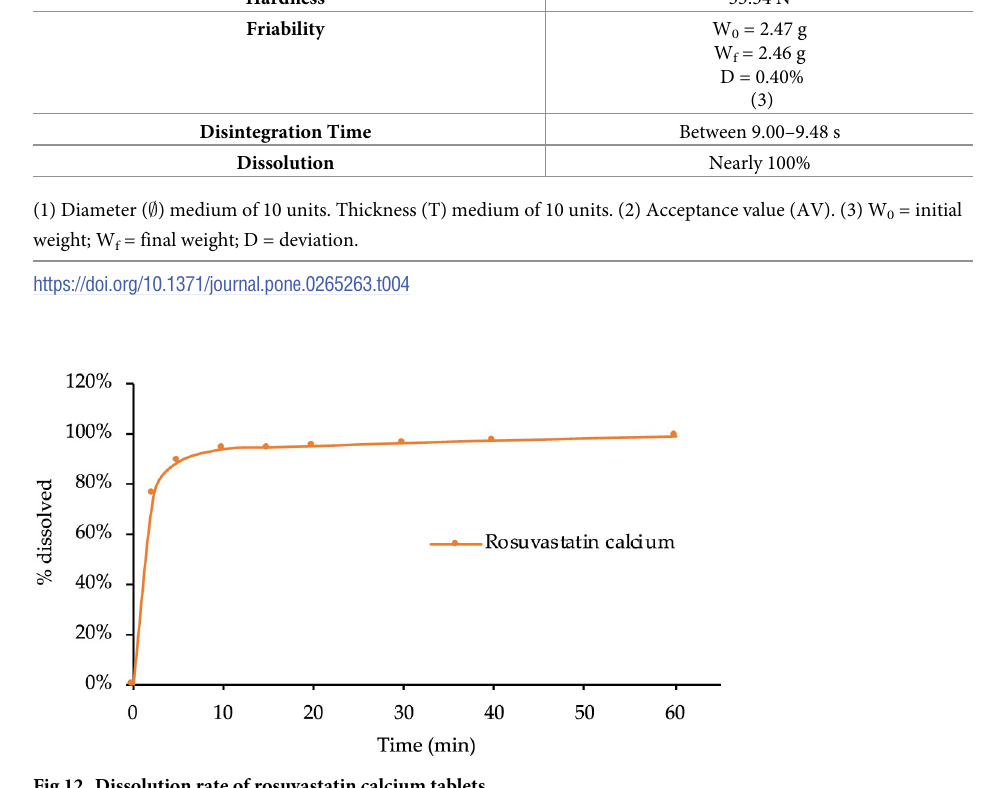
Fig 12. Dissolution rate of rosuvastatin calcium